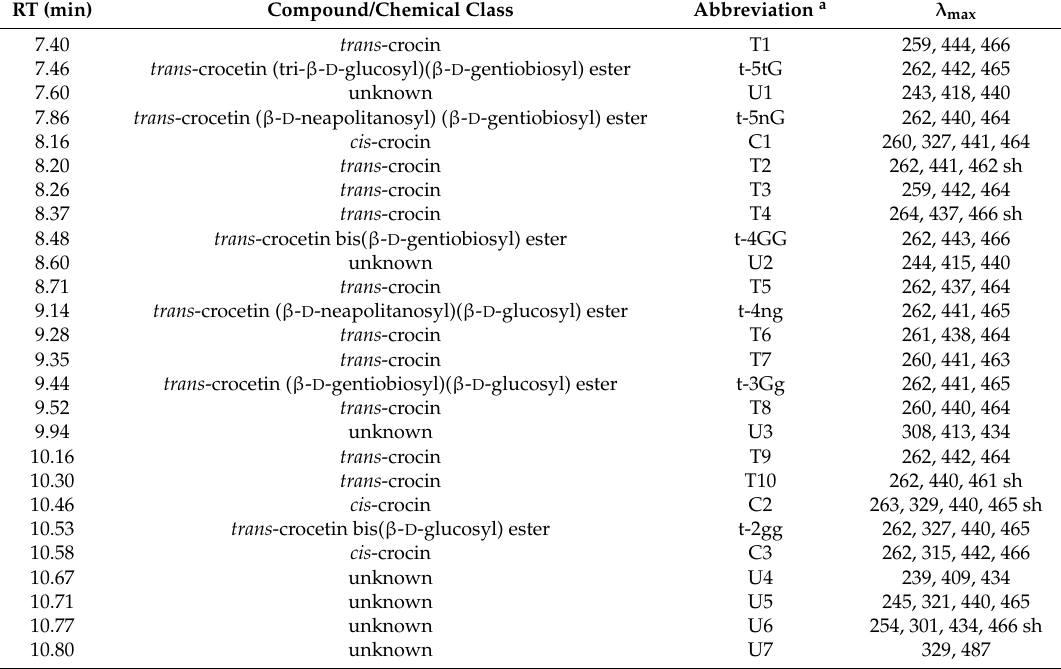
Table 2. List of the saffron metabolites found in the UHPLC-DAD chromatograms detected at 440 nm collected with the Luna Omega Polar C18 column under the conditions described in Section 3.4: retention time (RT), assigned structure or chemical class, absolute and relative maxima of the absorption